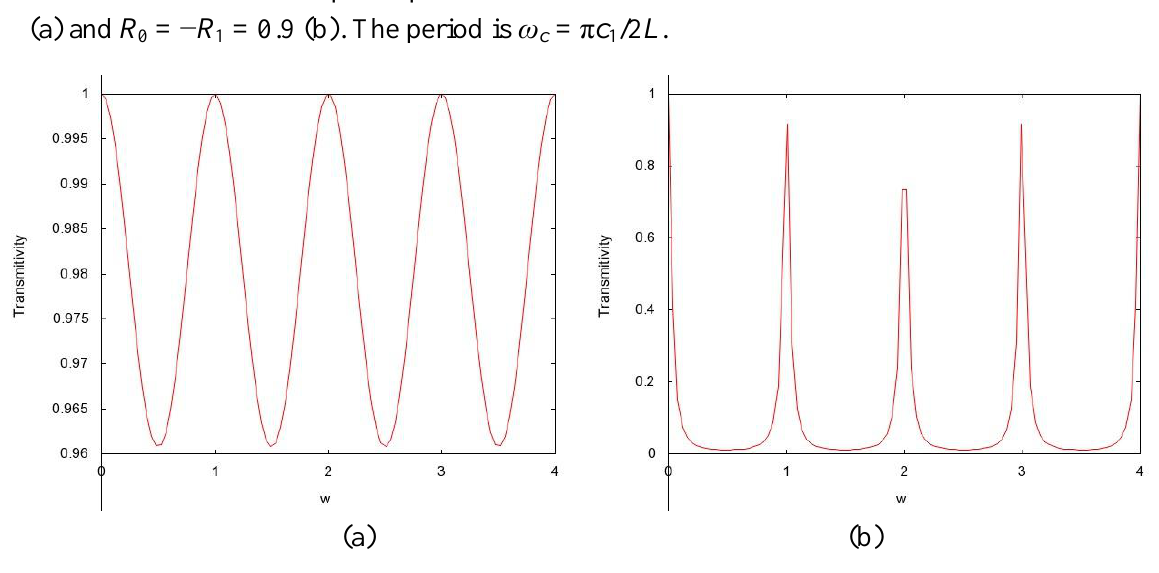
2 versus frequency for a single layer with R